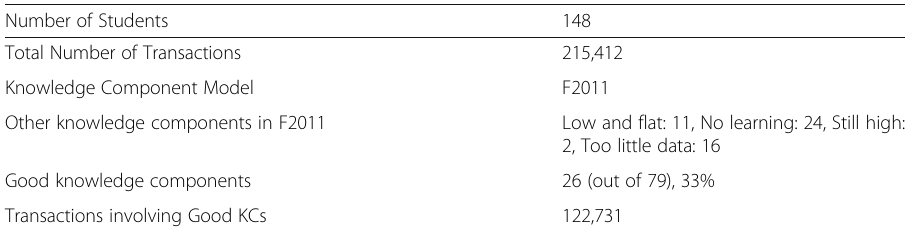
Table 9 Engineering statics course data summary